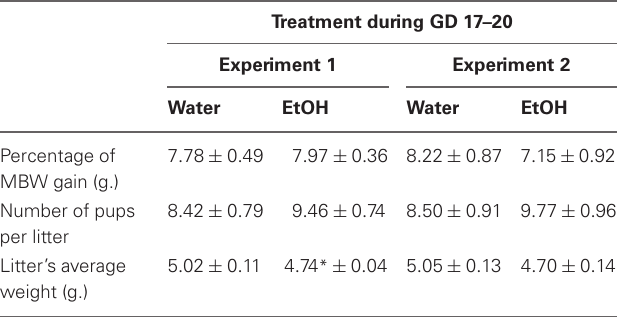
Table 1 | Maternal and neonatal physical parameters registered in Experiments 1 and 2, as a function of prenatal treatments.